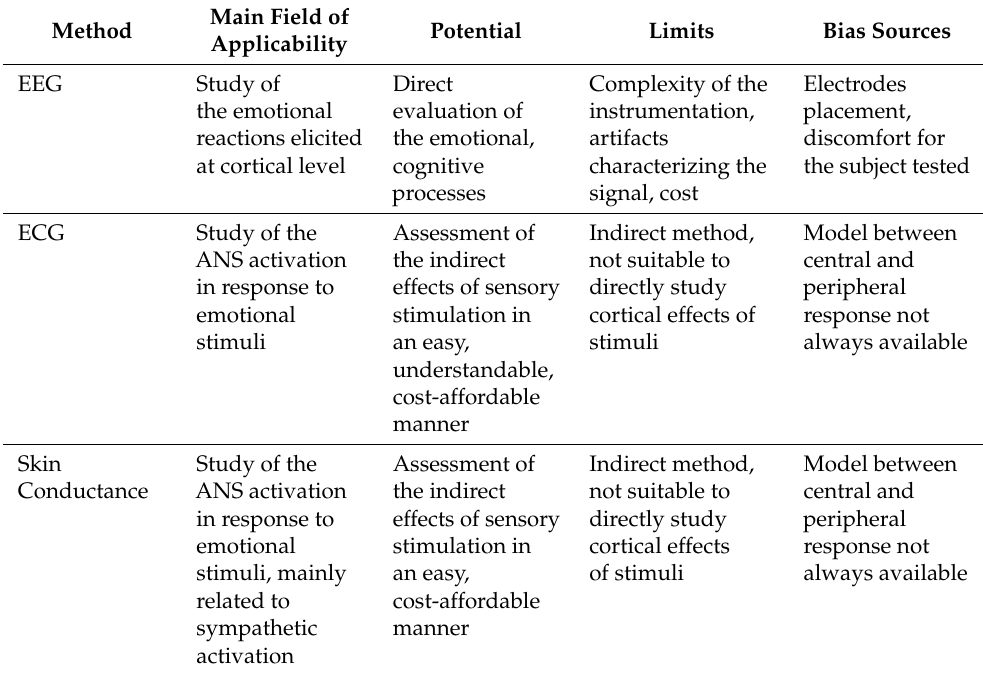
Electrodes placement, discomfort for the subject tested Model between central and peripheral response not always available Model between central and peripheral response